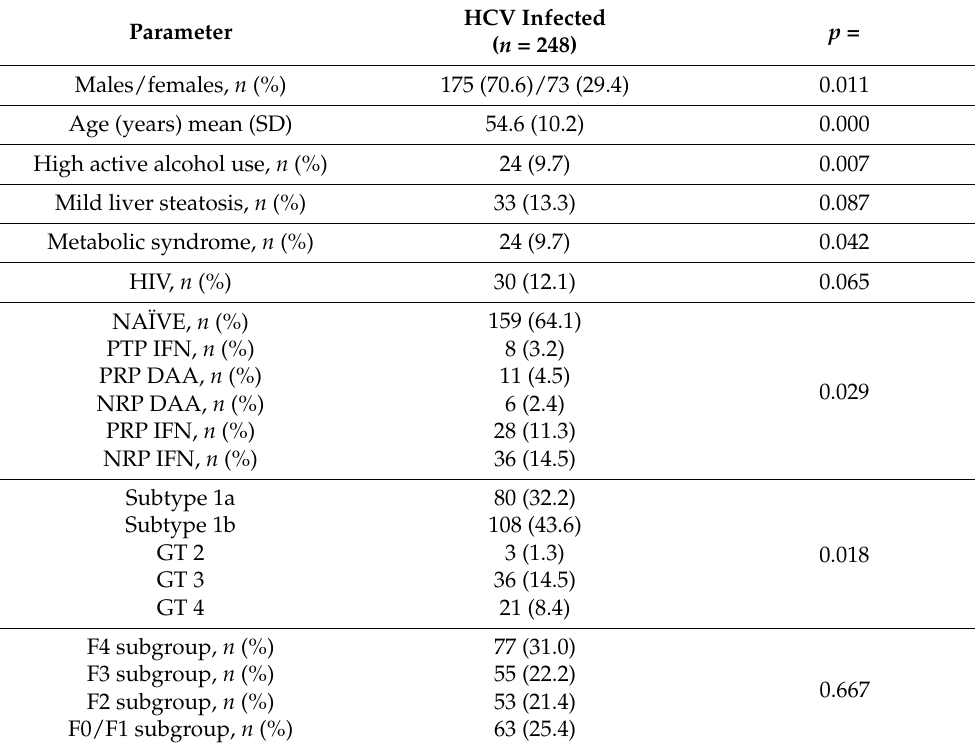
Table 2. Quantitative description of each baseline